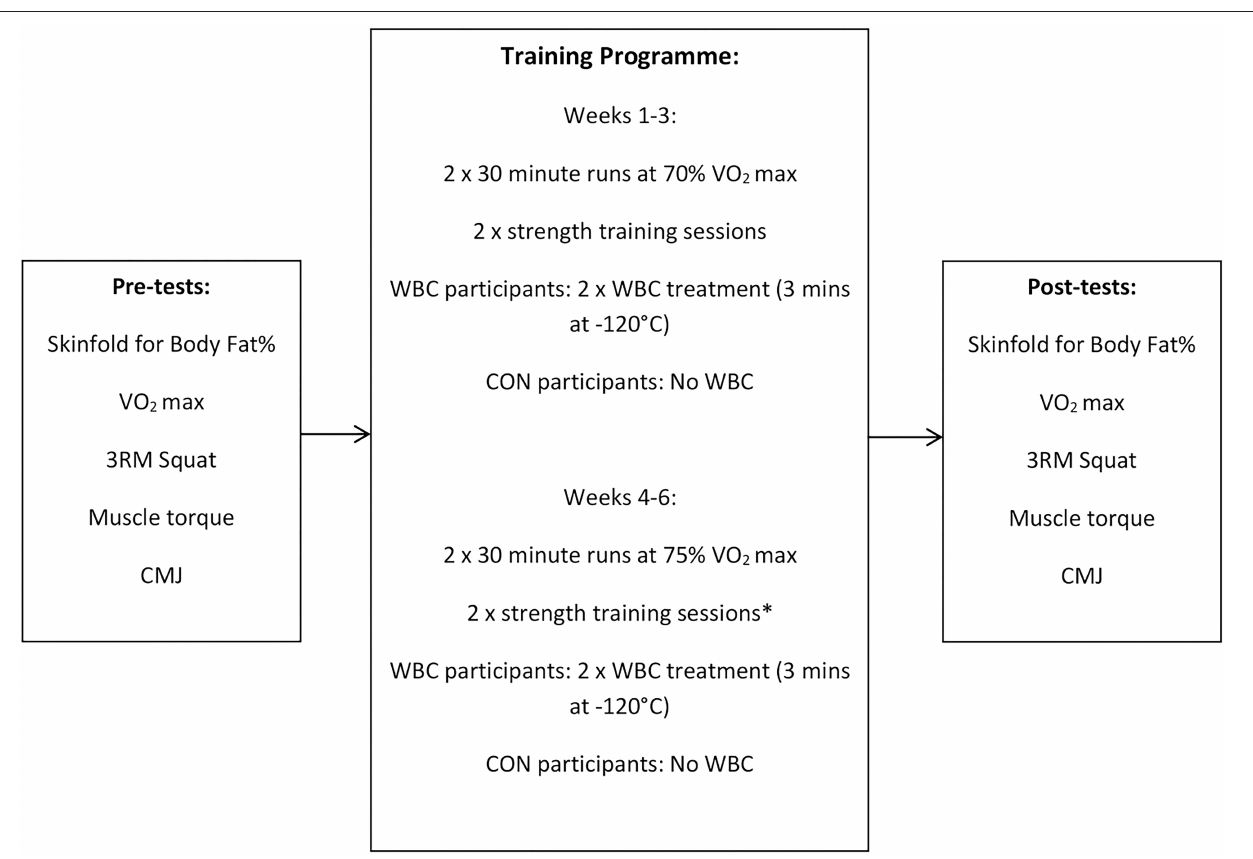
FIGURE 1 | Summary of design for training study with 4 sessions performed weekly. WBC, whole body cryotherapy; CON, control; 3RM, 3 repetition maximum; CMJ, countermovement jump test. *Weight for barbell squat progressed from 70% 1RM to 75% 1RM after 3